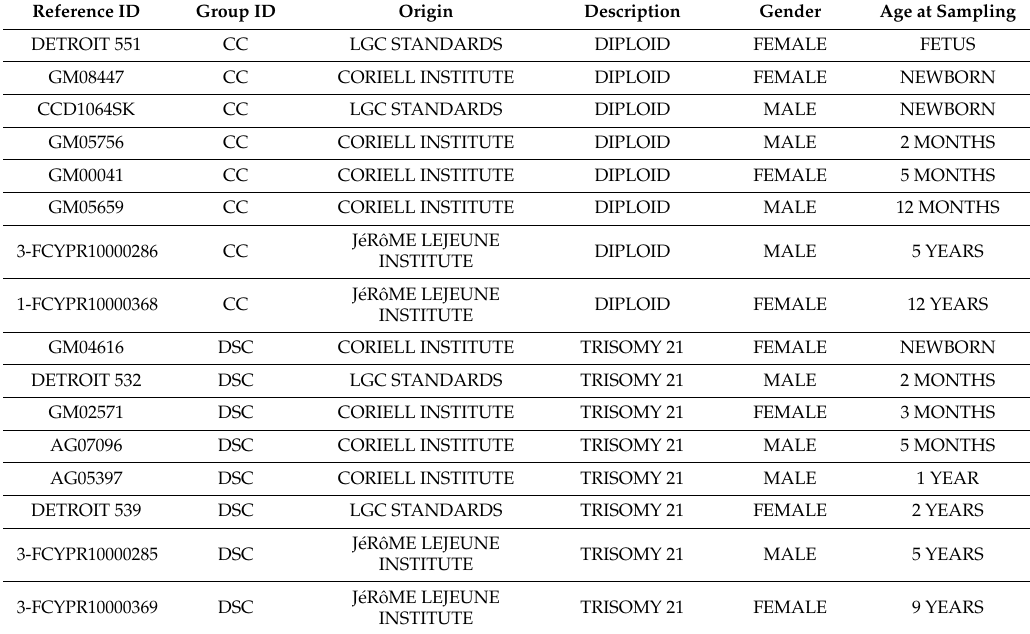
Table 1. Description and origin of the human dermal fibroblasts (control cells: CC and Down syndrome cells: DSC) used in the present